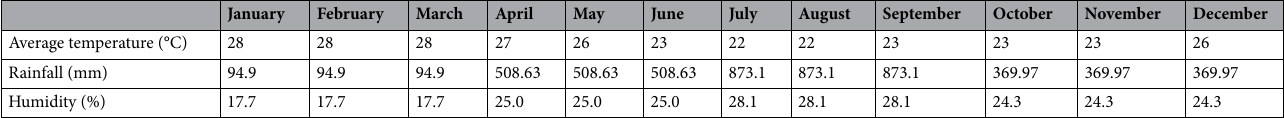
Table 7. Average monthly climatic parameters in Santchou 2019. Source: IRAD